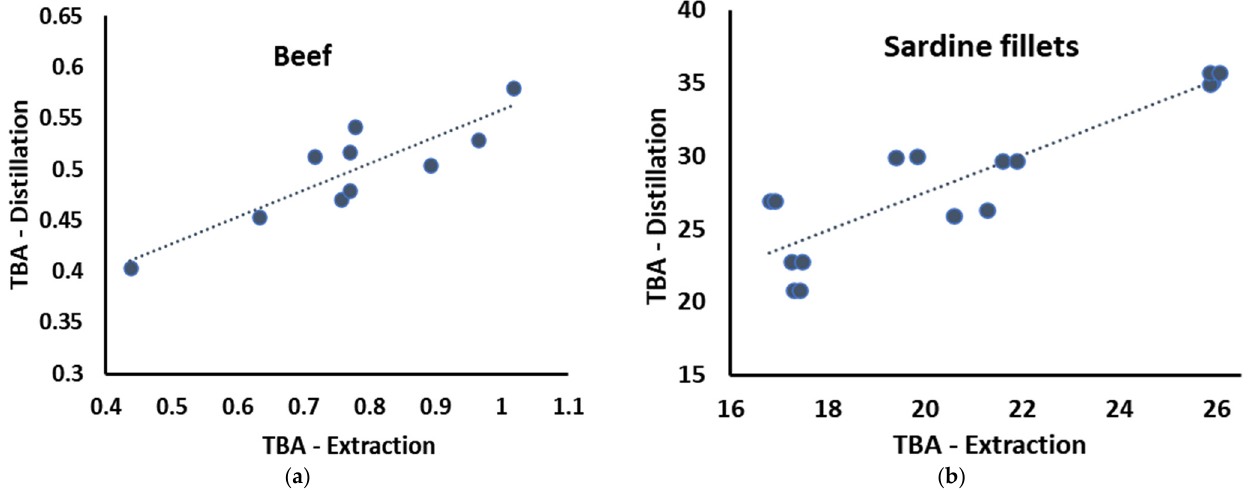
Figure 2. Correlation between the steam distillation and the modified extraction TBA method in different food samples. All TBA values in mg MA/kg. ( a ) ground beef; ( b ) sardine fillets.